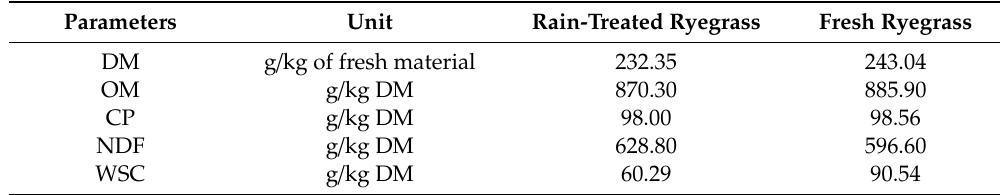
Table 1. Chemical composition of grass materials before ensiling.